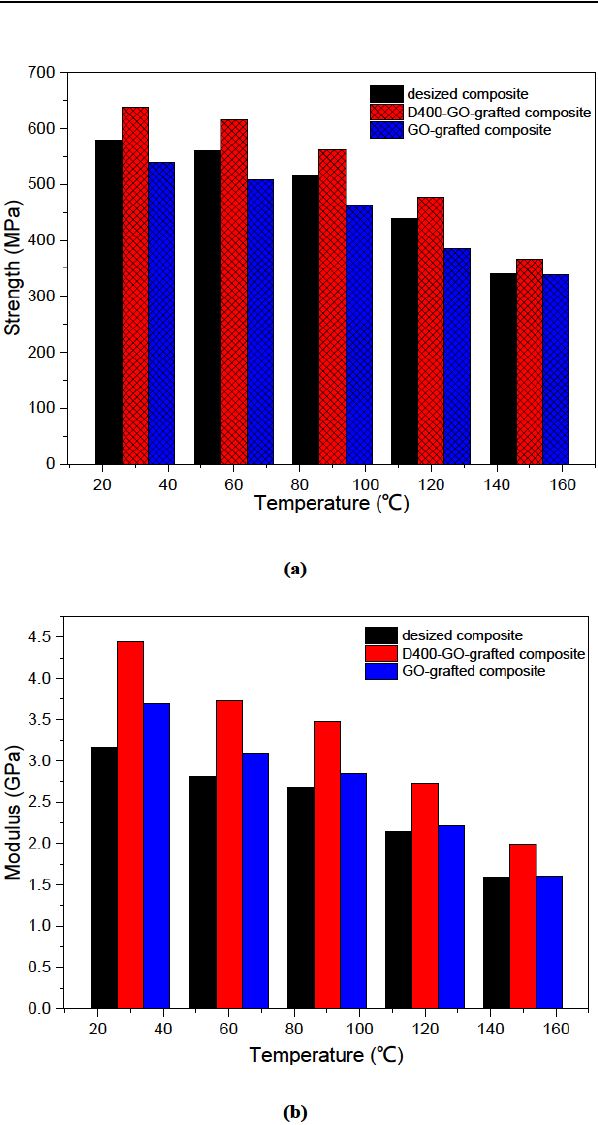
Figure 9: Out-of-plane compression properties of desized compos- ite, D 400 -GO-grafted composite, GO-grafted composite: (a) strength; (b)